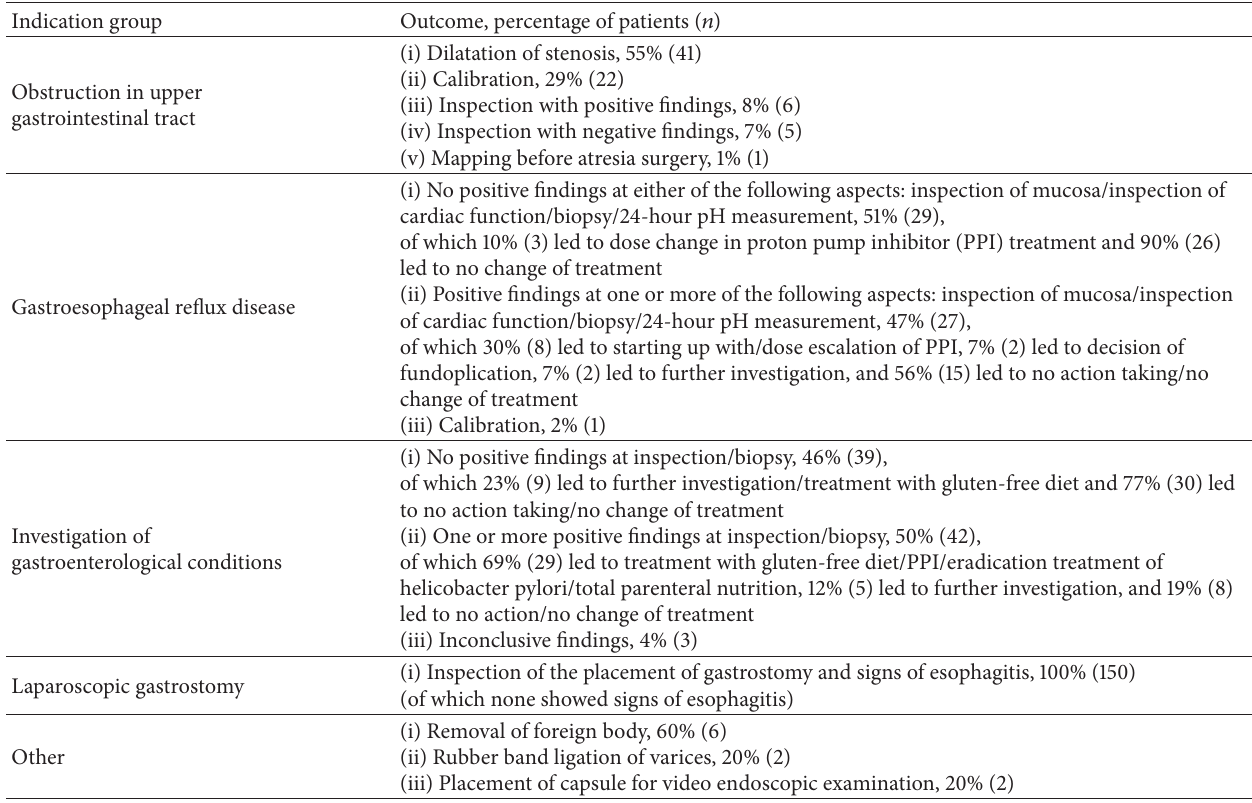
Table 1: Summary of the numbers and types of outcomes in the five indication